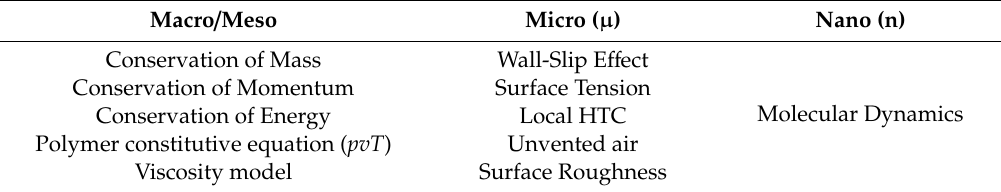
Table 2. Modeling governing equations and aspects for injection molding (IM) simulation depending on scale